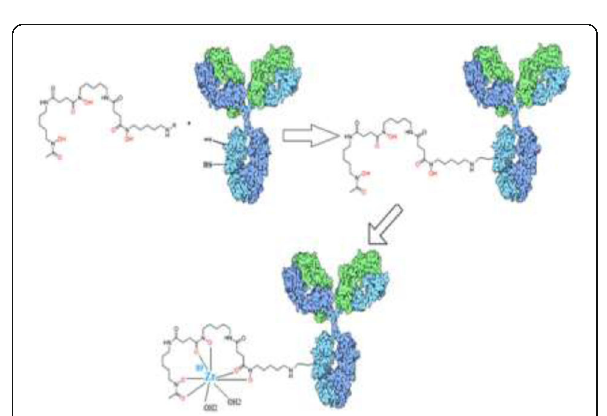
Fig. 2 (abstract PP10). See text for